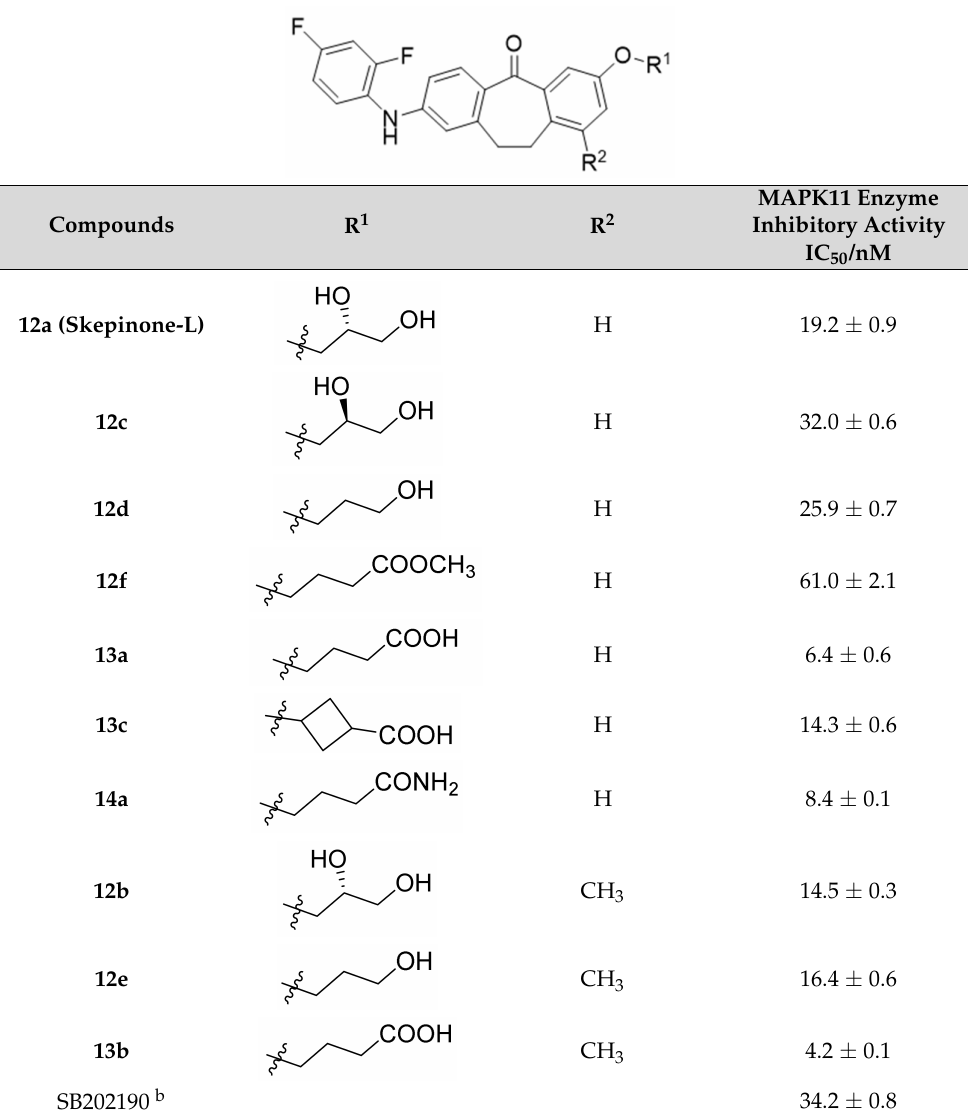
Table 1. Inhibitory activities of dibenzocycloheptanone derivatives against the MAPK11 enzyme a